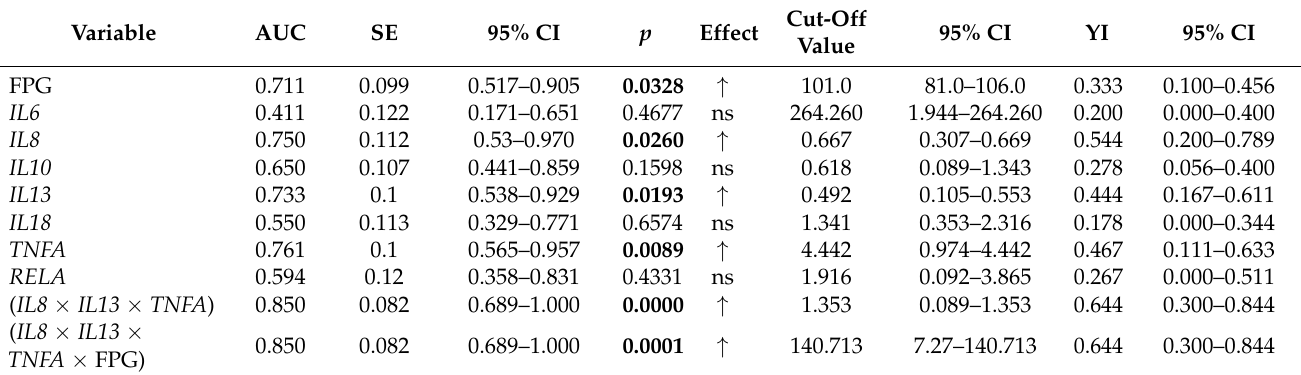
Table 6. The validity of pregnancy FPG and gene expression in predicting the AGT state at 1-year follow-up in women with prior GDM ( n = 28).